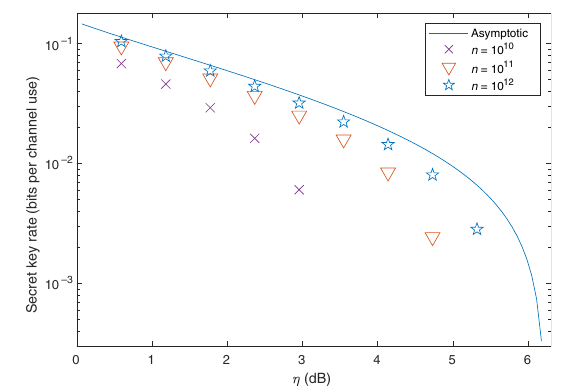
FIG. 2. The composable secret key rates versus the channel loss for QPSK encoding, for collective attacks in the regime of finite n . The channel parameters are | α | = 0.5, u = 0.001, and ξ = 0.97. The solid line is the theoretical rate expected in the asymptotic limit of n → ∞ and for ideal heterodyne detection, from Ref. [16]. For nonideal heterodyne, the expected rate is computed from the finite-dimensional semidefinite programs and by taking into account finite-size corrections as described in Sec. IX. For d = 16 and R = 7, the plot shows the results for n = 10 10 (crosses), n = 10 11 (triangles), and n = 10 12 (stars). The error parameters are (cid:16) h = (cid:16) s = (cid:16) PE = 10 − 10